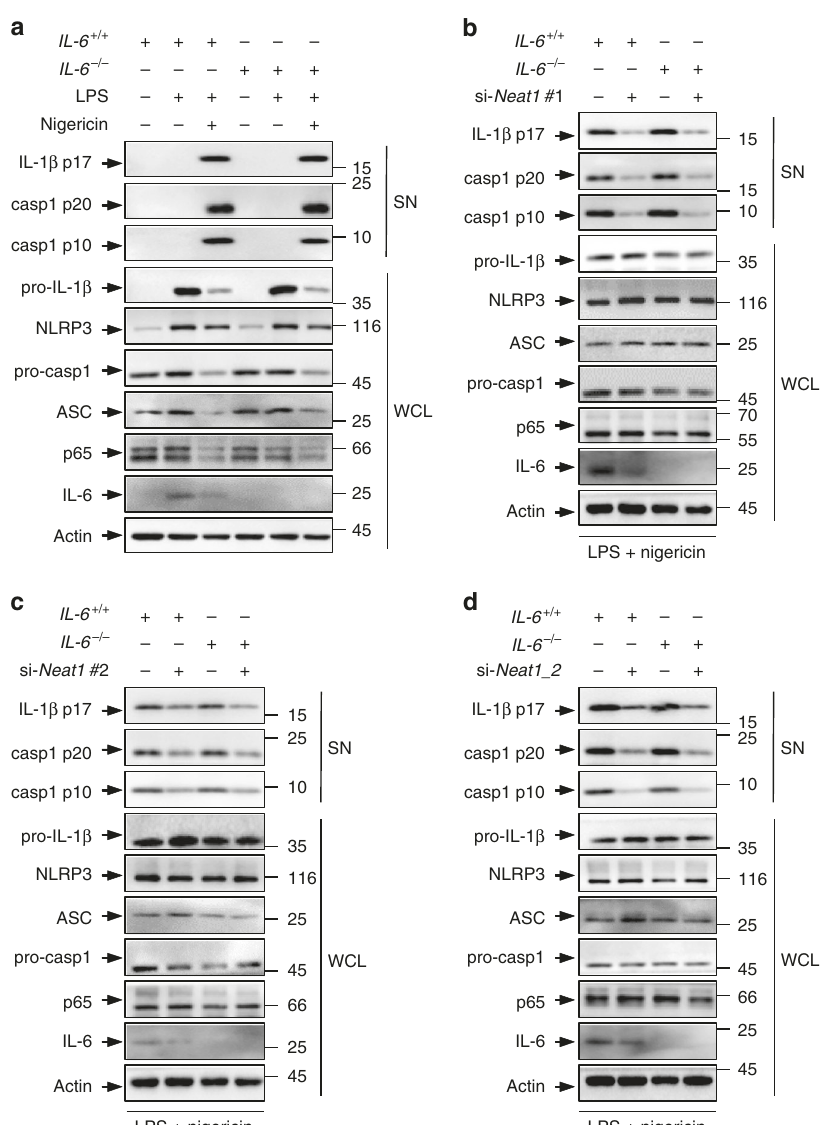
Fig. 3 The effect of Neat1 on the NLRP3 in fl ammasome activation is independent of IL-6. a BMDMs derived from IL-6 wild-type ( IL-6 + / + ) or knockout ( IL-6 − / − ) mice were primed with LPS and then treated with nigericin. Protein levels in total cell lysates and supernatant fraction were analyzed by western blotting. b – d IL-6 + / + or IL-6 − / − BMDMs were transfected with control siRNA ( b – d ), Neat1 siRNA #1 ( b ), Neat1 siRNA #2 ( c ), or Neat1_2 siRNA ( d ). Twenty-four hours later, cells were stimulated with LPS and nigericin. WCL and SN of above cells were subjected to western blotting with indicated antibodies. Source data are provided as a Source Data fi